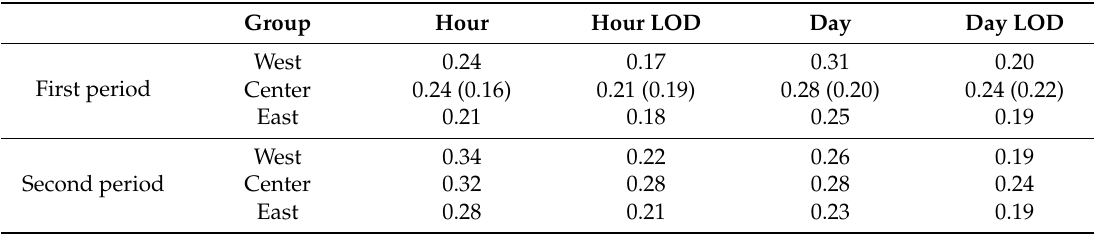
Figure 5. ( A ) COD between hourly averaged concentrations measured by Speck units and TEOM located at the Rochester DEC site, dependent on the distance from the DEC site. ( B ) The same for daily averages. If the units from the three groups (denoted in Figure 6 as thick squares) are considered separately, the mean COD decreased to at or below 0.2 for the LOD-corrected data outside the city center (Table 5), suggesting homogenous concentrations within the groups. The mean COD values in individual groups are not the same, but there is no statistically significant difference between the groups (evaluated by Dunn’s test [29]). Table 5. Mean COD values between each Speck PM concentration pair calculated from hourly and daily averages, from the original and LOD corrected data (denoted as LOD in the table) in the three separate geographical groups. In the city center, the mean value from all pairs, with the exclusion of V13, is presented (in the brackets).